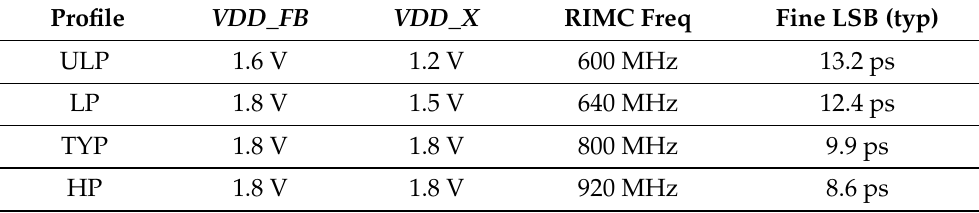
Table 1. Supply voltage and oscillation frequency settings for each profile. VDD_FB corresponds to the Frontend and Backend Readout blocks’ power supply, while VDD_X corresponds to the oscillator power supply.